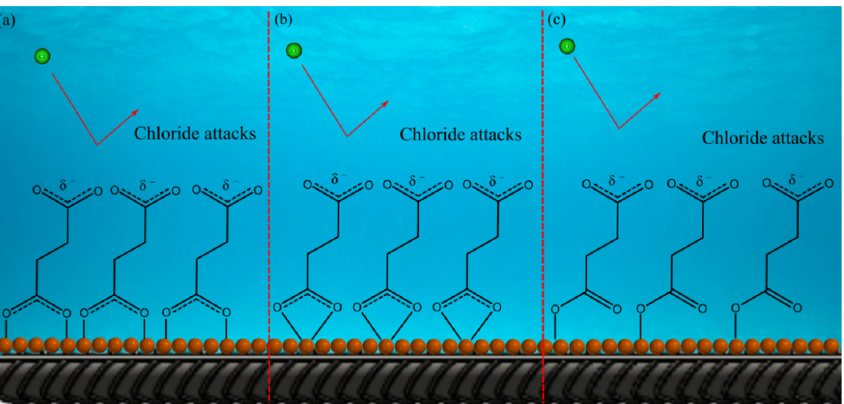
Figure 2. The three main adsorption modes of R–COO– of sodium succinate on the metal surface: ( a ) η -shape mode, ( b ) bridging mode, and ( c ) chelating mode. Dashed line represents partial π -bonds due to carboxylate resonance. The formation of an adsorption film will repel chloride ions, thus protecting the carbon steel rebar. Ferrous ions are represented as orange spheres.